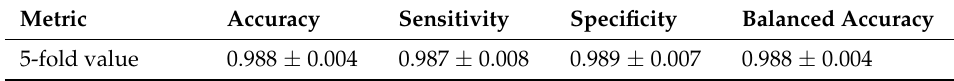
Table 4. Cross-validated test results of the best configuration